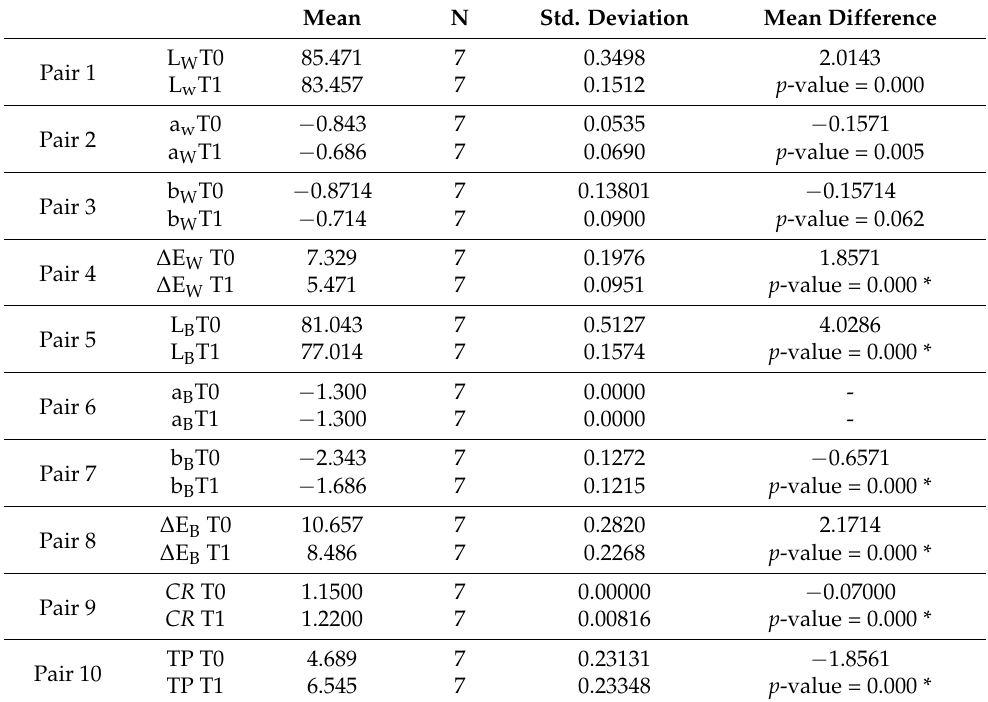
Table 5. Paired sample statistics (1400 ◦